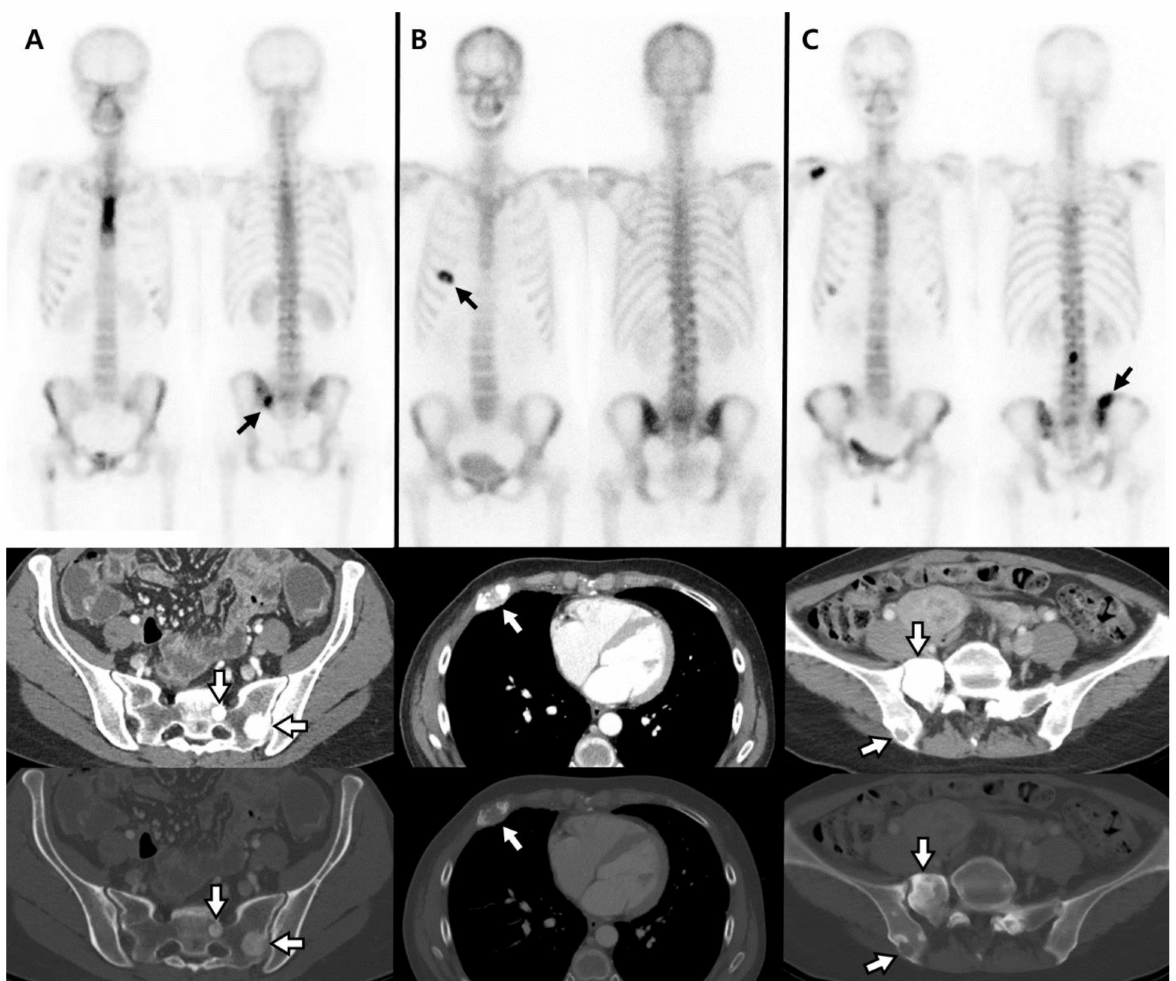
Figure 1. Examples of three subgroups classified by radiologic pattern. ( A ) Metastatic bone lesion in the left ala of the sacrum, which had increased radiotracer uptake on bone scintigraphy (black arrows), showed osteosclerotic change on CT image (white arrows). ( B ) Bone metastasis in the anterior arc of the right fifth rib showed increased radiotracer uptake with central photon deficiency on bone scintigraphy (black arrow) and osteolytic metastasis on CT image (white arrow). ( C ) Hot lesions were seen in the right iliac bone and sacrum on bone scintigraphy (black arrow), while on CT image (white arrows), metastatic lesion in the right iliac bone showed osteolytic change and, in the sacrum, osteosclerotic change (mixed type of bone